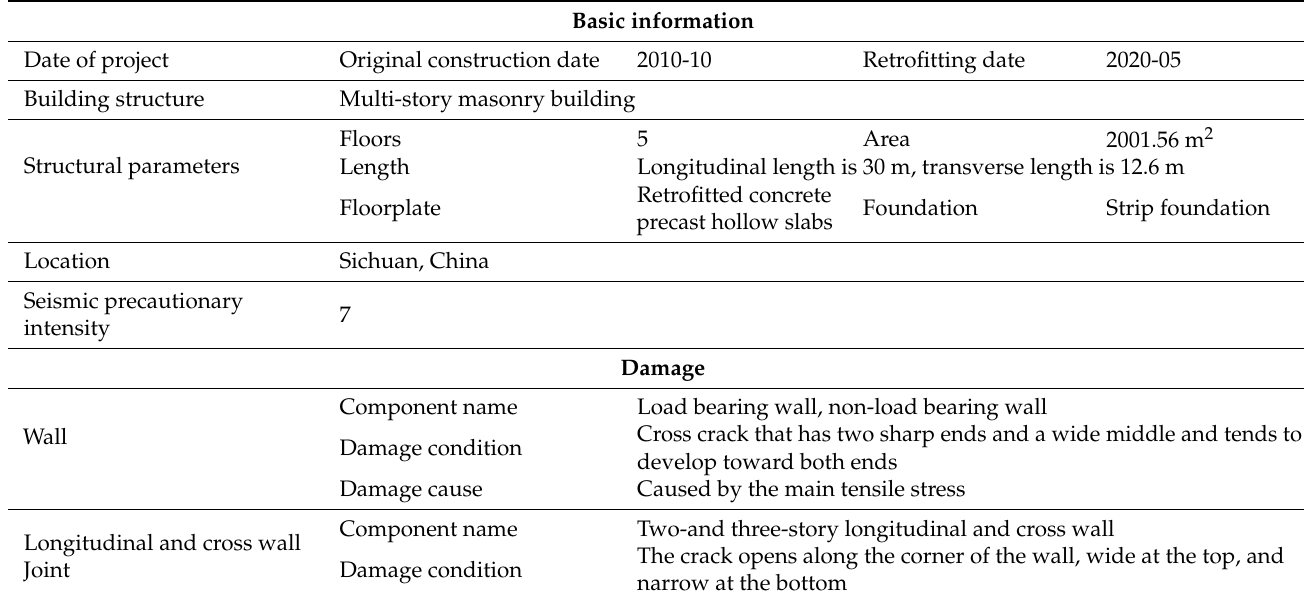
Table 2. Information collection